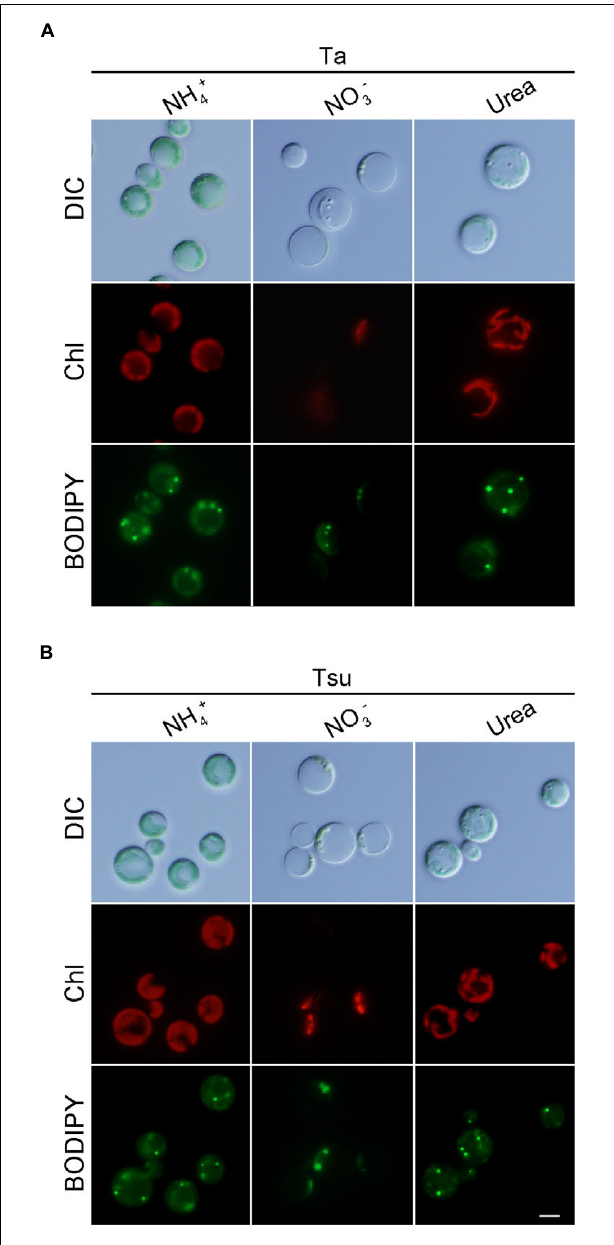
FIGURE 4 | Microscopic observation of G. sulphuraria 074G cells in media derived from acidic hot spring waters with different nitrogen sources. (A,B) Micrographs of cells that were cultured in Ta (A) or Tsu (B) supplemented with different nitrogen sources. Cells cultured in the synthetic MA medium (OD 750 of 1.0–2.0) were collected by centrifugation, resuspended into the respective media to give an OD 750 of 1.0 and then cultured for 14 days. Images obtained by differential interference contrast microscopy (DIC), autofluorescence of chloroplasts (Chl) and BODIPY staining (BODIPY) are shown. Scale bar = 5 µ